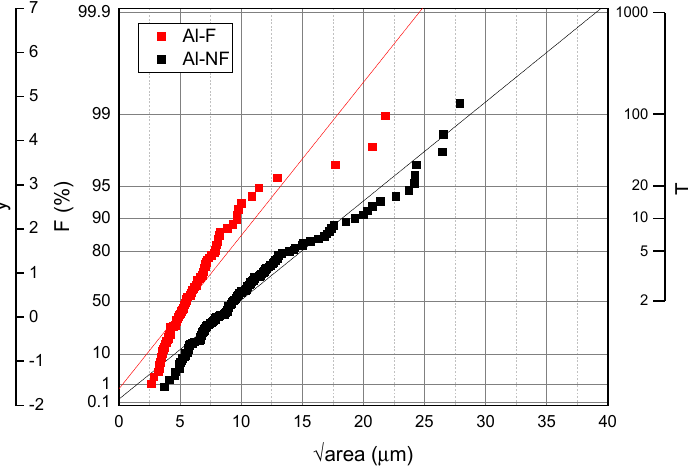
Figure 9. The cumulative frequency of the extreme values of the inclusion Figure 9 . The cumulative frequency of the extreme values of the inclusion size.